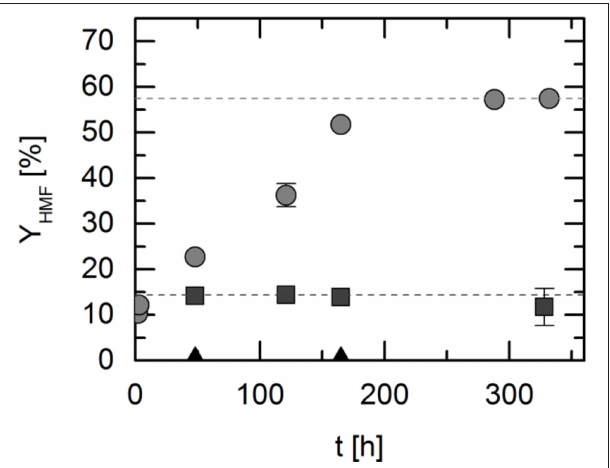
FIGURE 1 | HMF yield over time in choline chloride (ChCl) dissolved in water (triangles), in pure levulinic acid (LA; squares) and in the corresponding deep eutectic system (DES ChCl:LA 1:2; circles); fructose starting concentration: 2.5 wt.%; reaction temperature 323K; pressure 1 bar. Data listed in Table S2 .